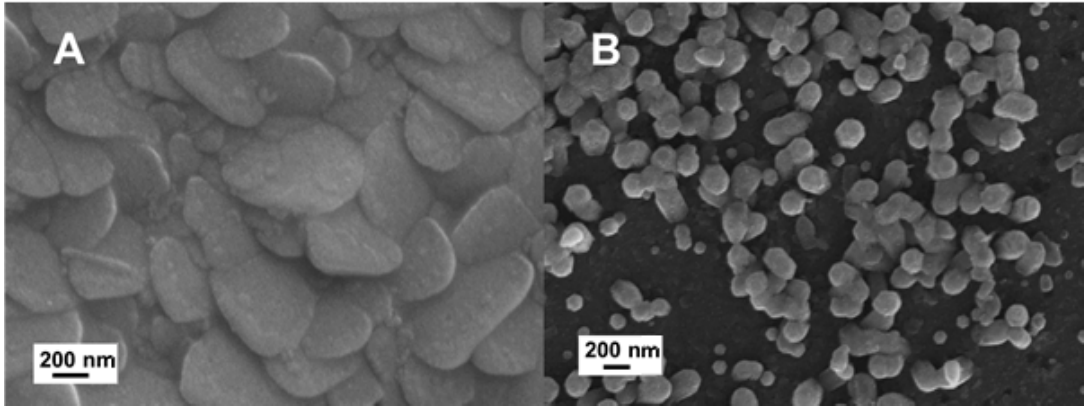
Figure 1. Representative SEM images of nanostructured fluorine (F)-doped ZnO (nZnO·F) ( A ) and nZnO ( B ).